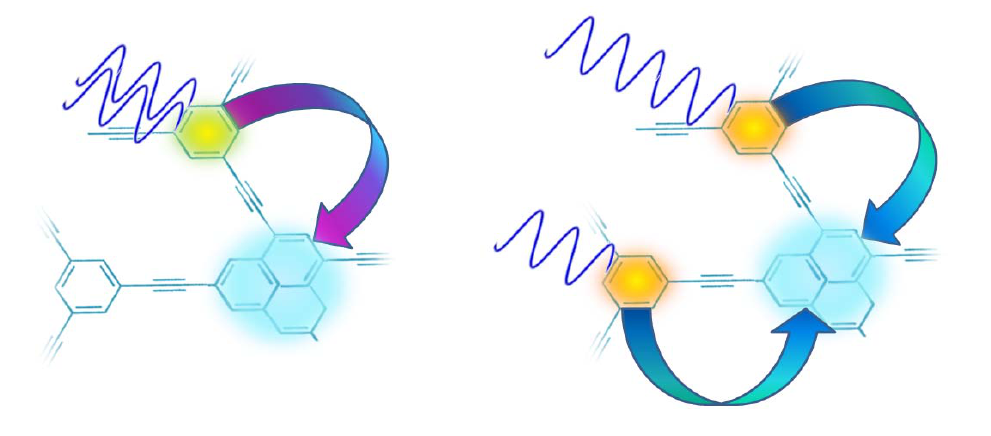
Figure 9. Alternative mechanisms for delivering the energy of two photons, captured by one or more higher-generation or peripheral antenna chromophores, to a lower generation neighbour (specific dendrimer components shown only for illustration): ( a ) direct transfer of the energy acquired by two-photon absorption in a single outer chromophore ( b ) the pooling of energy from two outer chromophores, each individually excited by single-photon